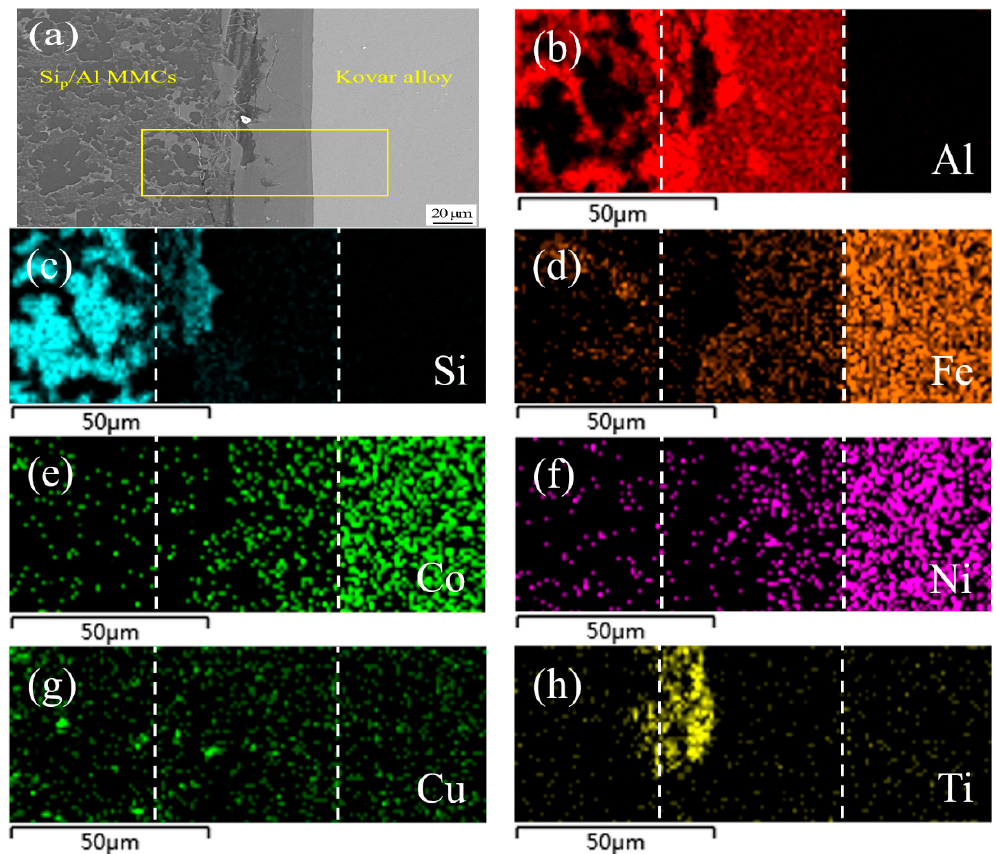
Figure 8. SEM images of typical region at the interface of 50 wt.% Si p /Al MMCs/Kovar made using Al-7.5Si-23.0Cu-2.0Ni-2.5Ti at 580 °C for 30 min and corresponding energy dispersive X-ray maps showing distribution of elements: ( a ) SEM image; ( b – h ) individual elemental mapping of Al, Si, Fe, Co, Ni, Cu, and Ti,